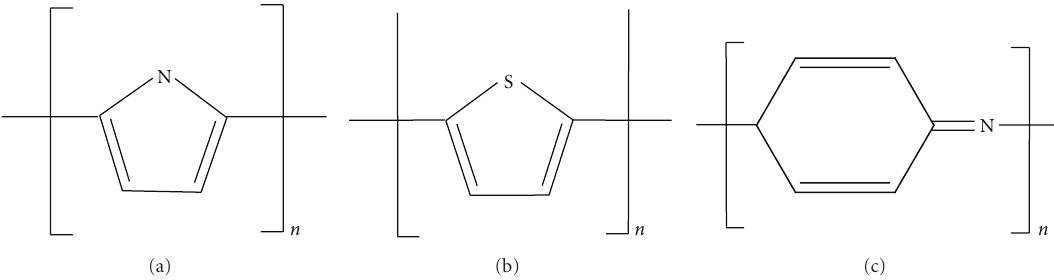
Figure 1: Typical conducting polymers: (a) polypyrrole (PPy), (b) polythiophen (PThio), and (c) polyaniline (PAni).